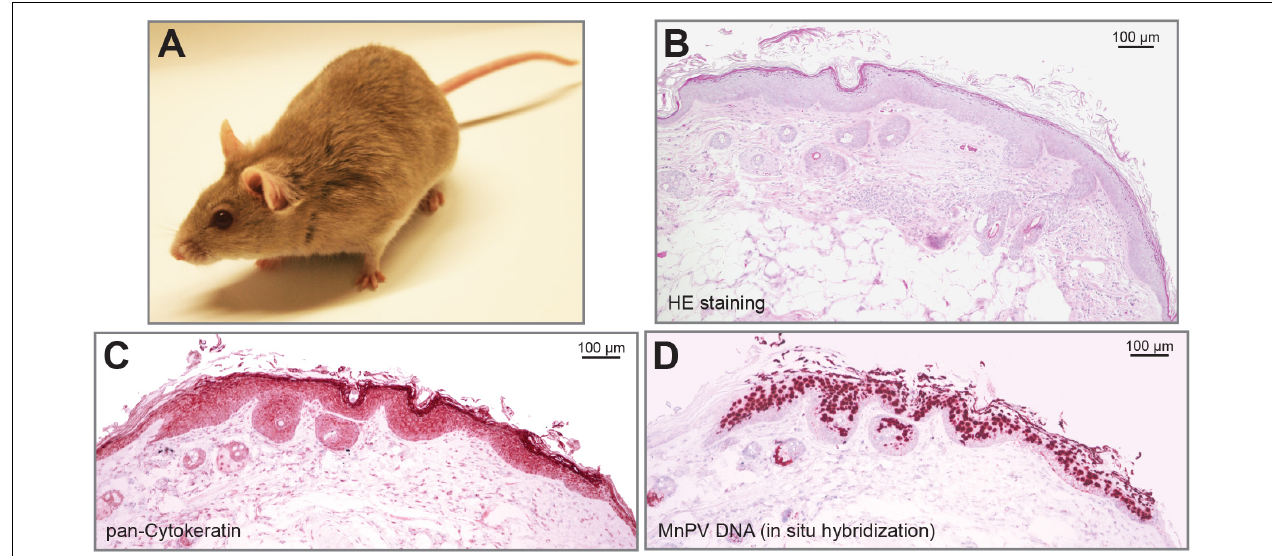
FIGURE 1 | The preclinical animal model Mastomys coucha develops MnPV-induced skin lesions. (A) A young Mastomys coucha . (B) HE staining of a dysplastic epithelium at the edge of a spontaneously emerging skin lesion. (C) Pan-cytokeratin staining shows the dysplasia of the epithelium. (D) In situ hybridization reveals squamous cells positive for MnPV